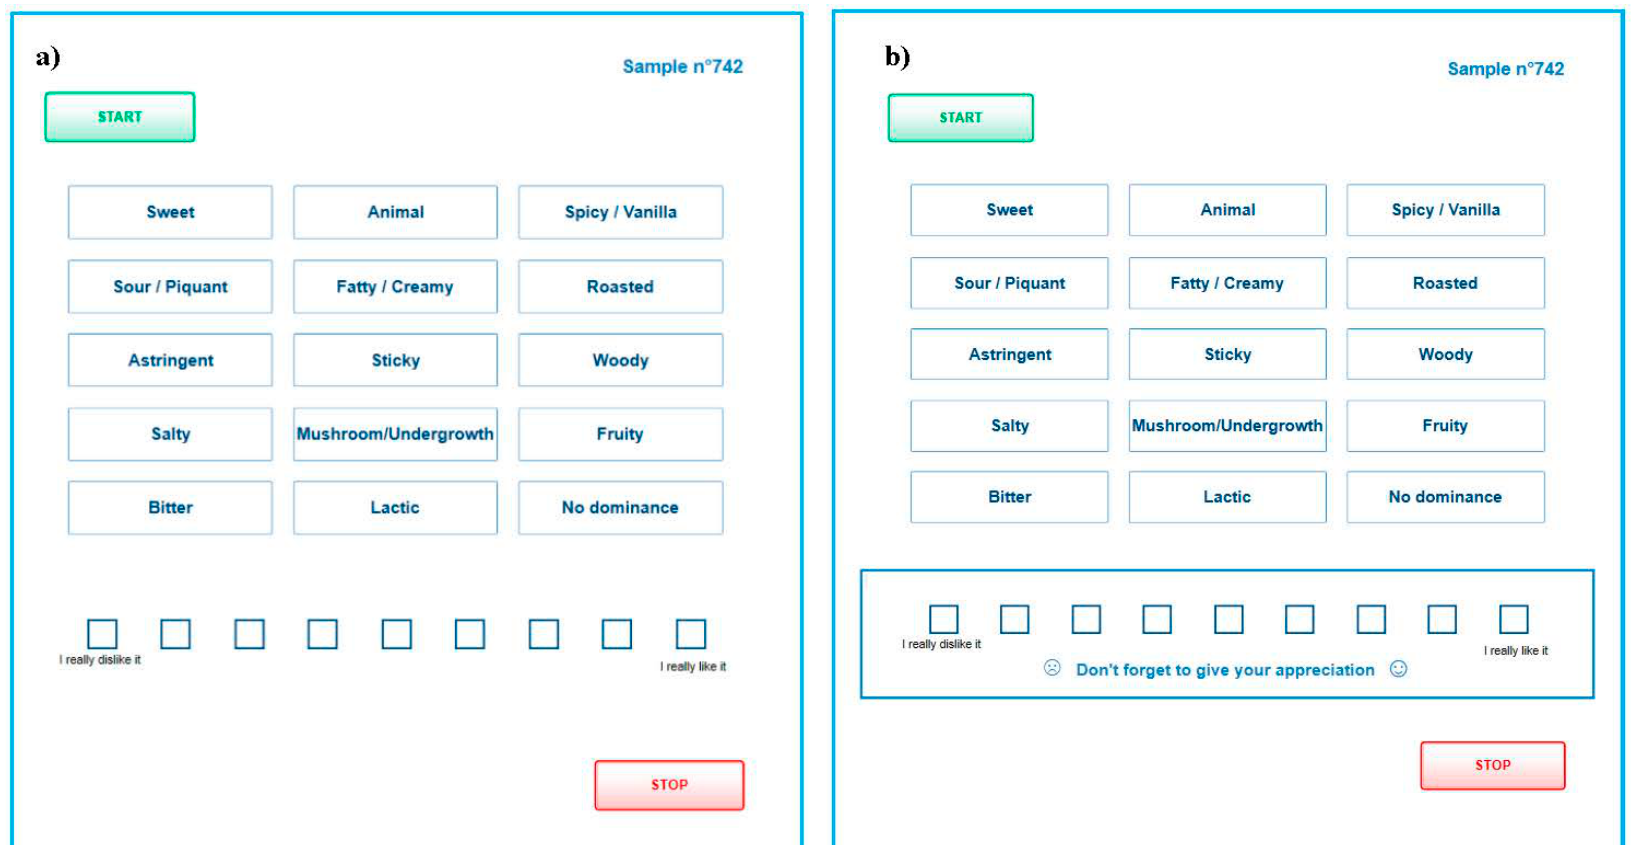
Figure 1. ( a , b ) Screenshots of the method used for data acquisition. The same screen was presented for the mono-intake evaluation of wine, mono-intake evaluation of cheese and for the multiple intake evaluation of the combination.